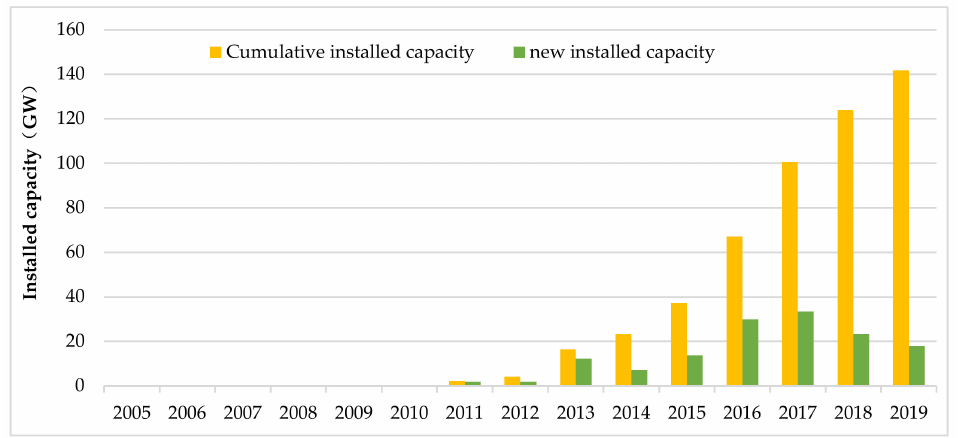
Figure 1. Cumulative installed capacity and new installed capacity of centralized photovoltaic